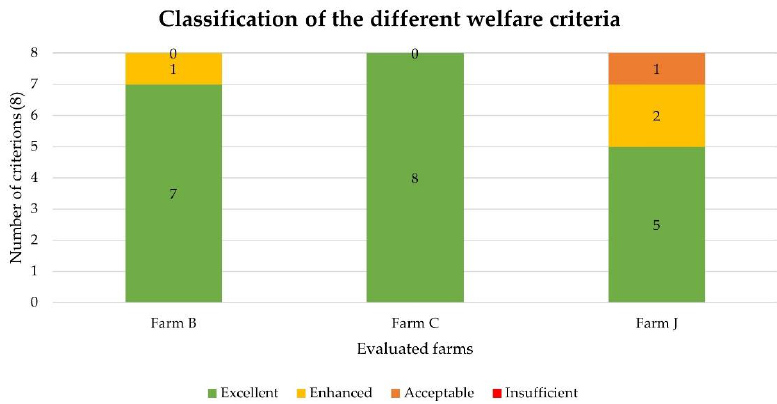
Figure 1. Number of criteria in each score level per farm.